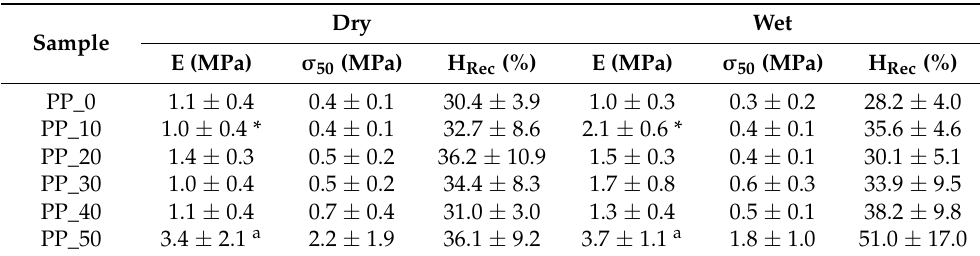
Data are reported as average ± standard deviation (measurements carried out on 5 samples for each kind of